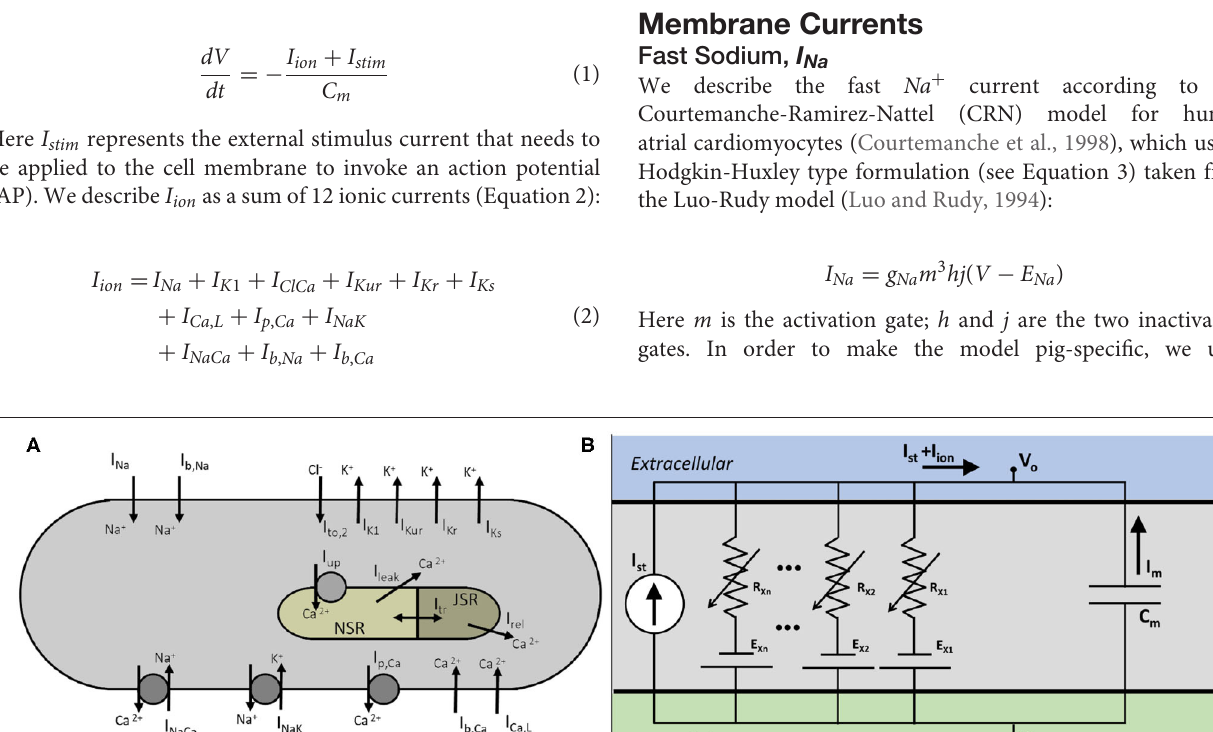
Frontiers in Physiology |